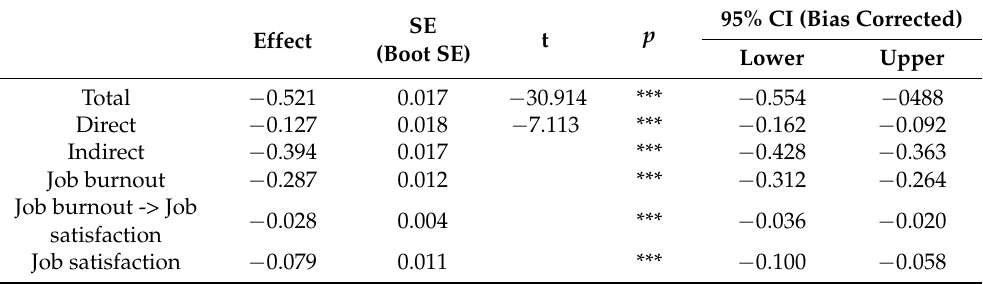
Table 4. Mediation effect.